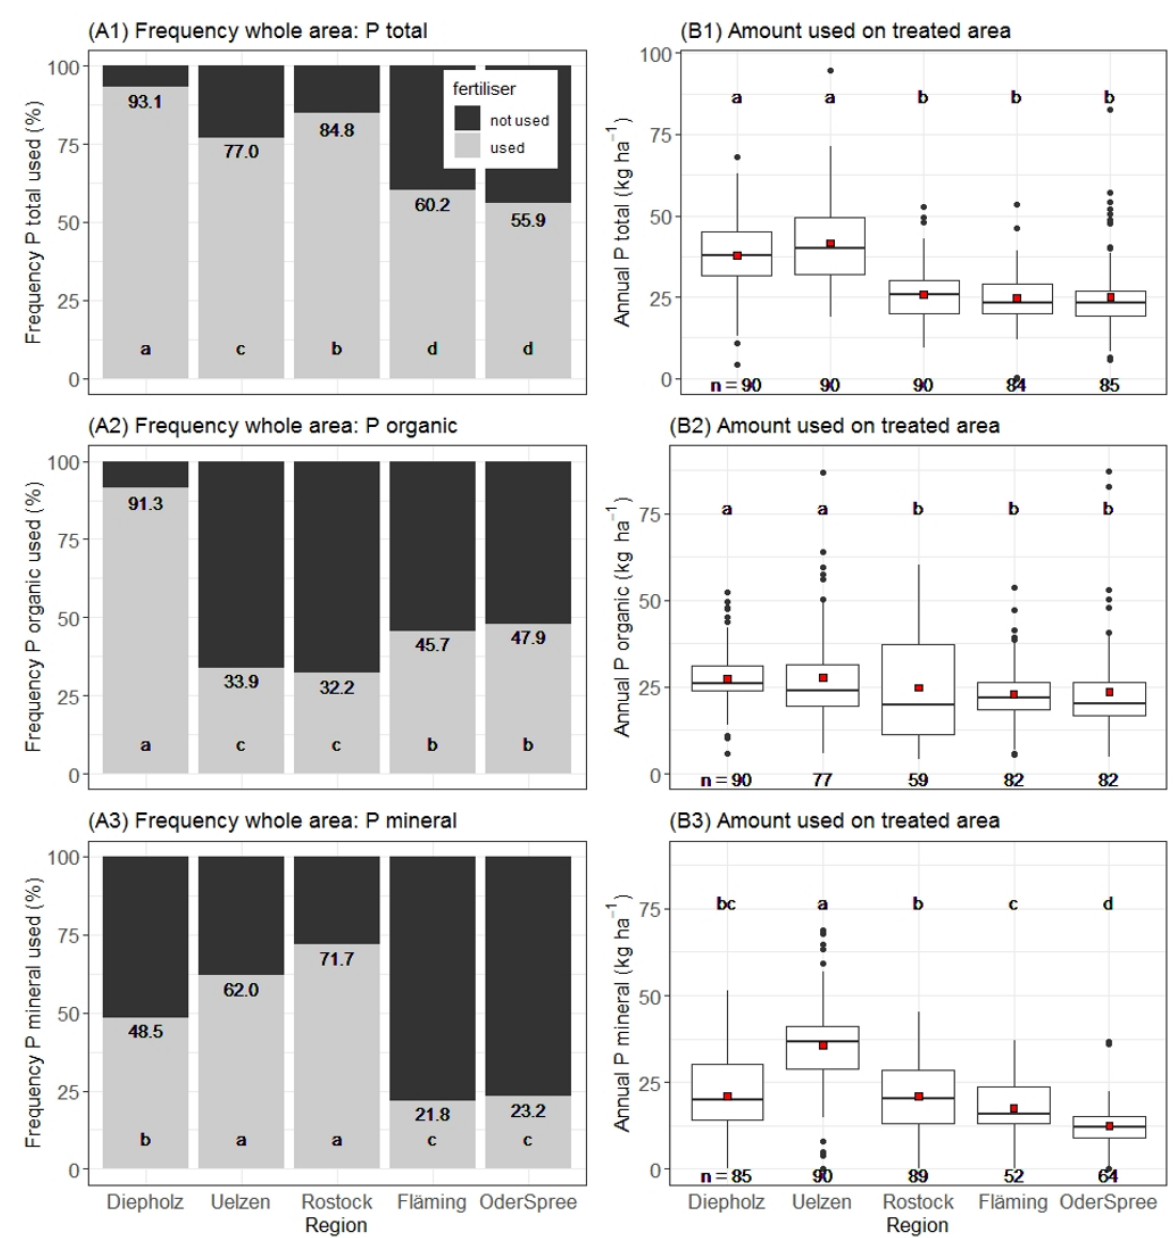
Figure 3. (A) Indicator frequency of P used on the whole area: ( A1 ) P total, ( A2 ) organic and ( A3 ) mineral P used. ( B ) Indicator amount of P used on the treated area only. N < 90 indicates that in some years some farms did not use P. All values are given per region (Diepholz, Uelzen, Rostock, Fläming and Oder-Spree) for the study period 2010–2018. The red square shows the mean. Different letters display a statistically significant difference between the regions (Kruskal–Wallis p < 0.05). Numbers are given in Appendix A (Table A1).